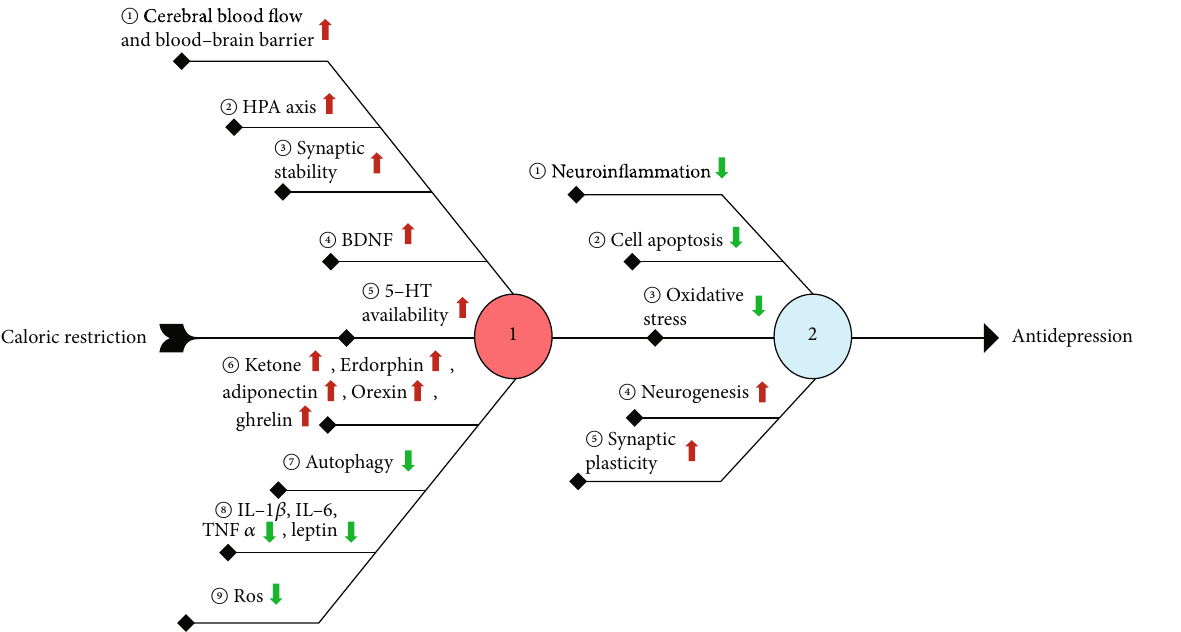
Figure 2: The molecular mechanism involved in the antidepressant e ff ect of caloric restriction.